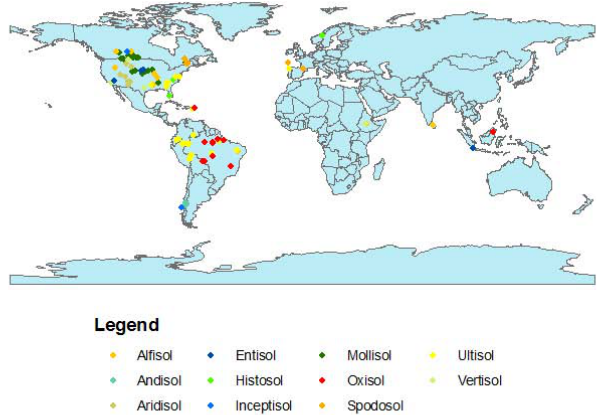
Fig. 1. Distribution of data locations. Some locations contain mul- tiple data